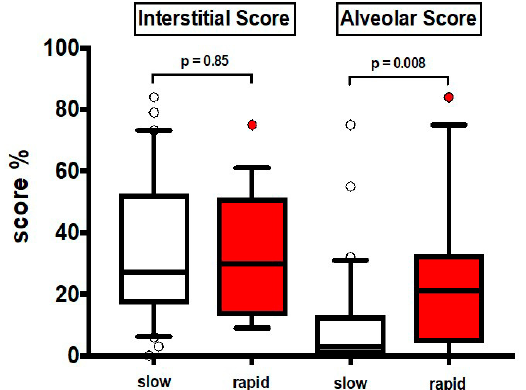
Figure 2. Values of HRCT 1 Interstitial Score and Alveolar Score at baseline in slow progressors (slow) and rapid progressors (rapid). Horizontal bars represent median values; bottom and top of each box plot 25th and 75th; brackets show 10th and 90th percentiles; and circles represent outliers. White boxes indicate slow progressors and red boxes rapid progressors.